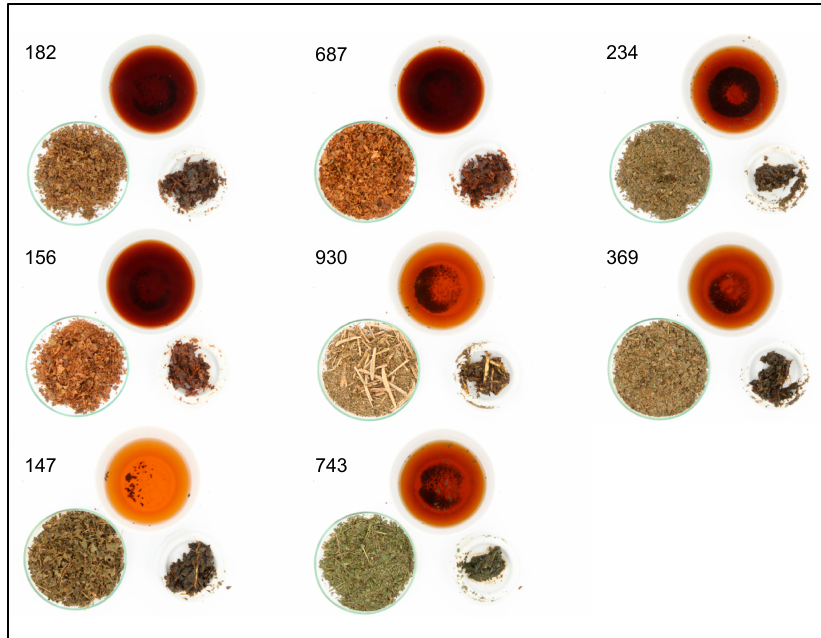
Figure 12. Brewed tea samples along with brewed and unbrewed tea leaves of the best eight teas.